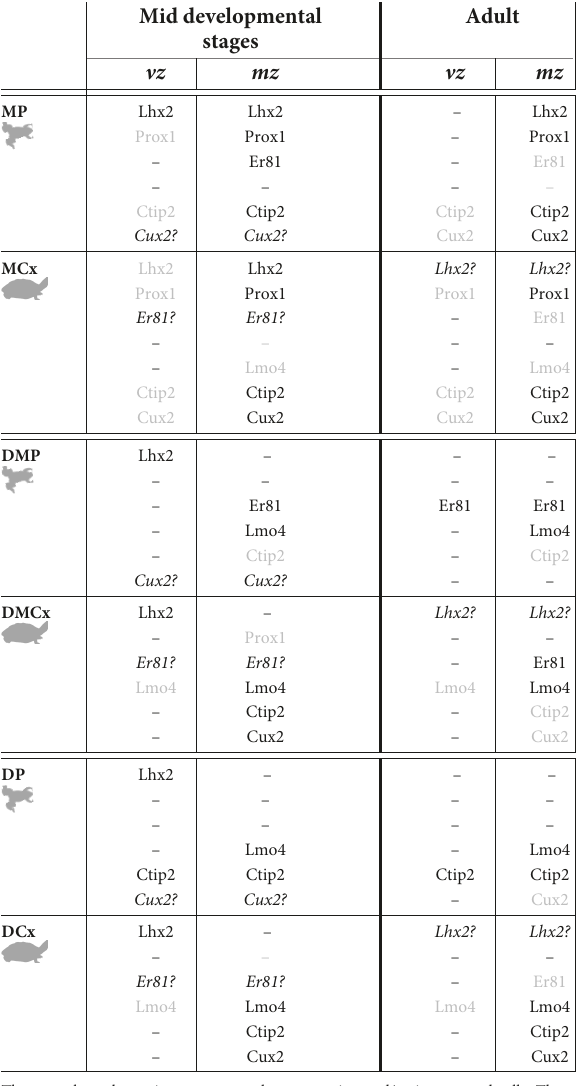
TABLE 3 Summary table showing the main expression patterns found for the genes analyzed in the present study, in the middle stages of development and in the adult, in the ventricular zone and out of the